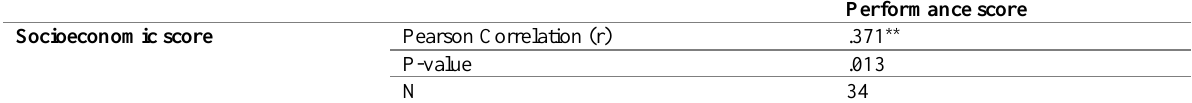
Table 8: Association between Children’s Socioeconomic Background and Performance